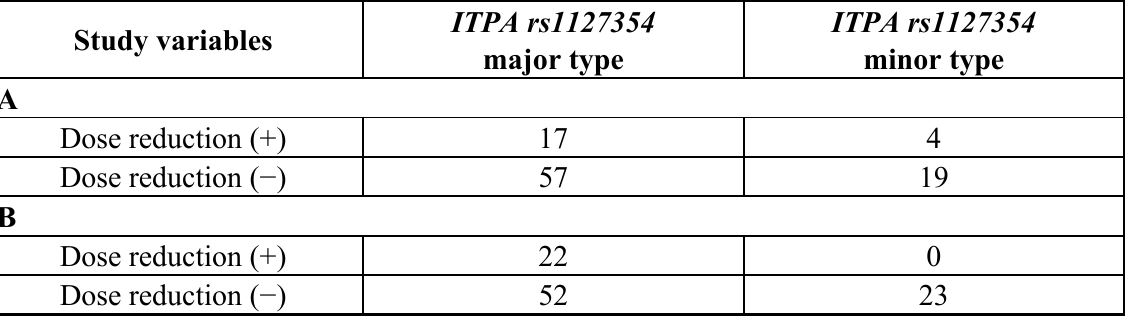
Table 4. Association between ITPA rs1127354 genotype and dose reduction of drugs